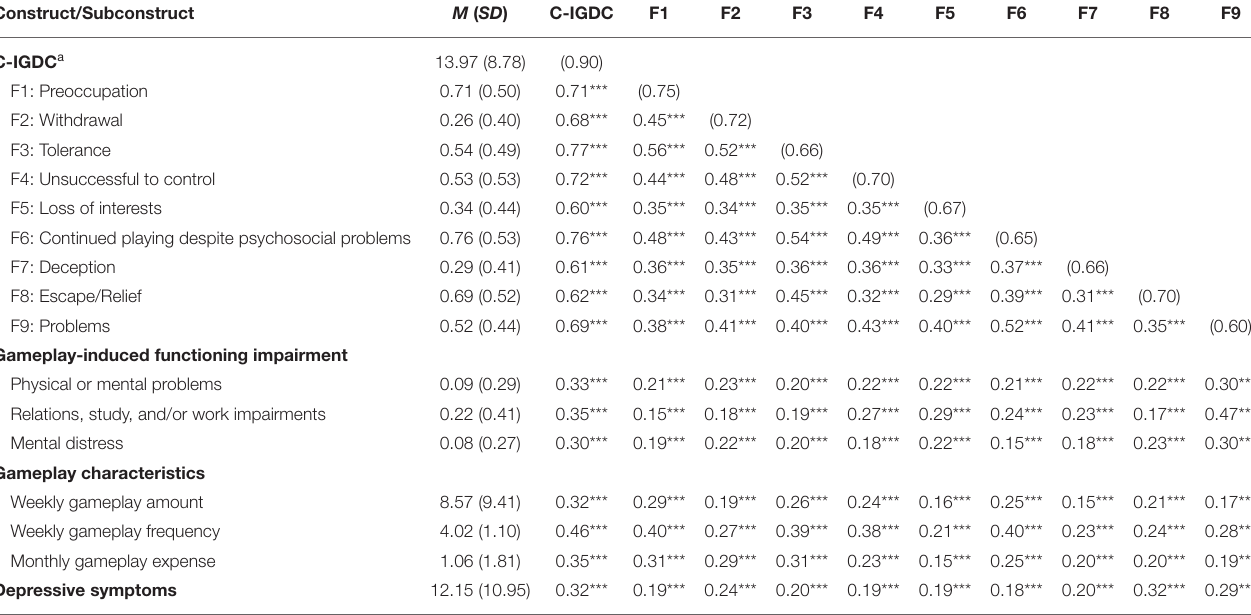
TABLE 2 | Reliability and bivariate correlations of C-IGDC construct and subconstruct scores ( N = 1,253). Construct/Subconstruct